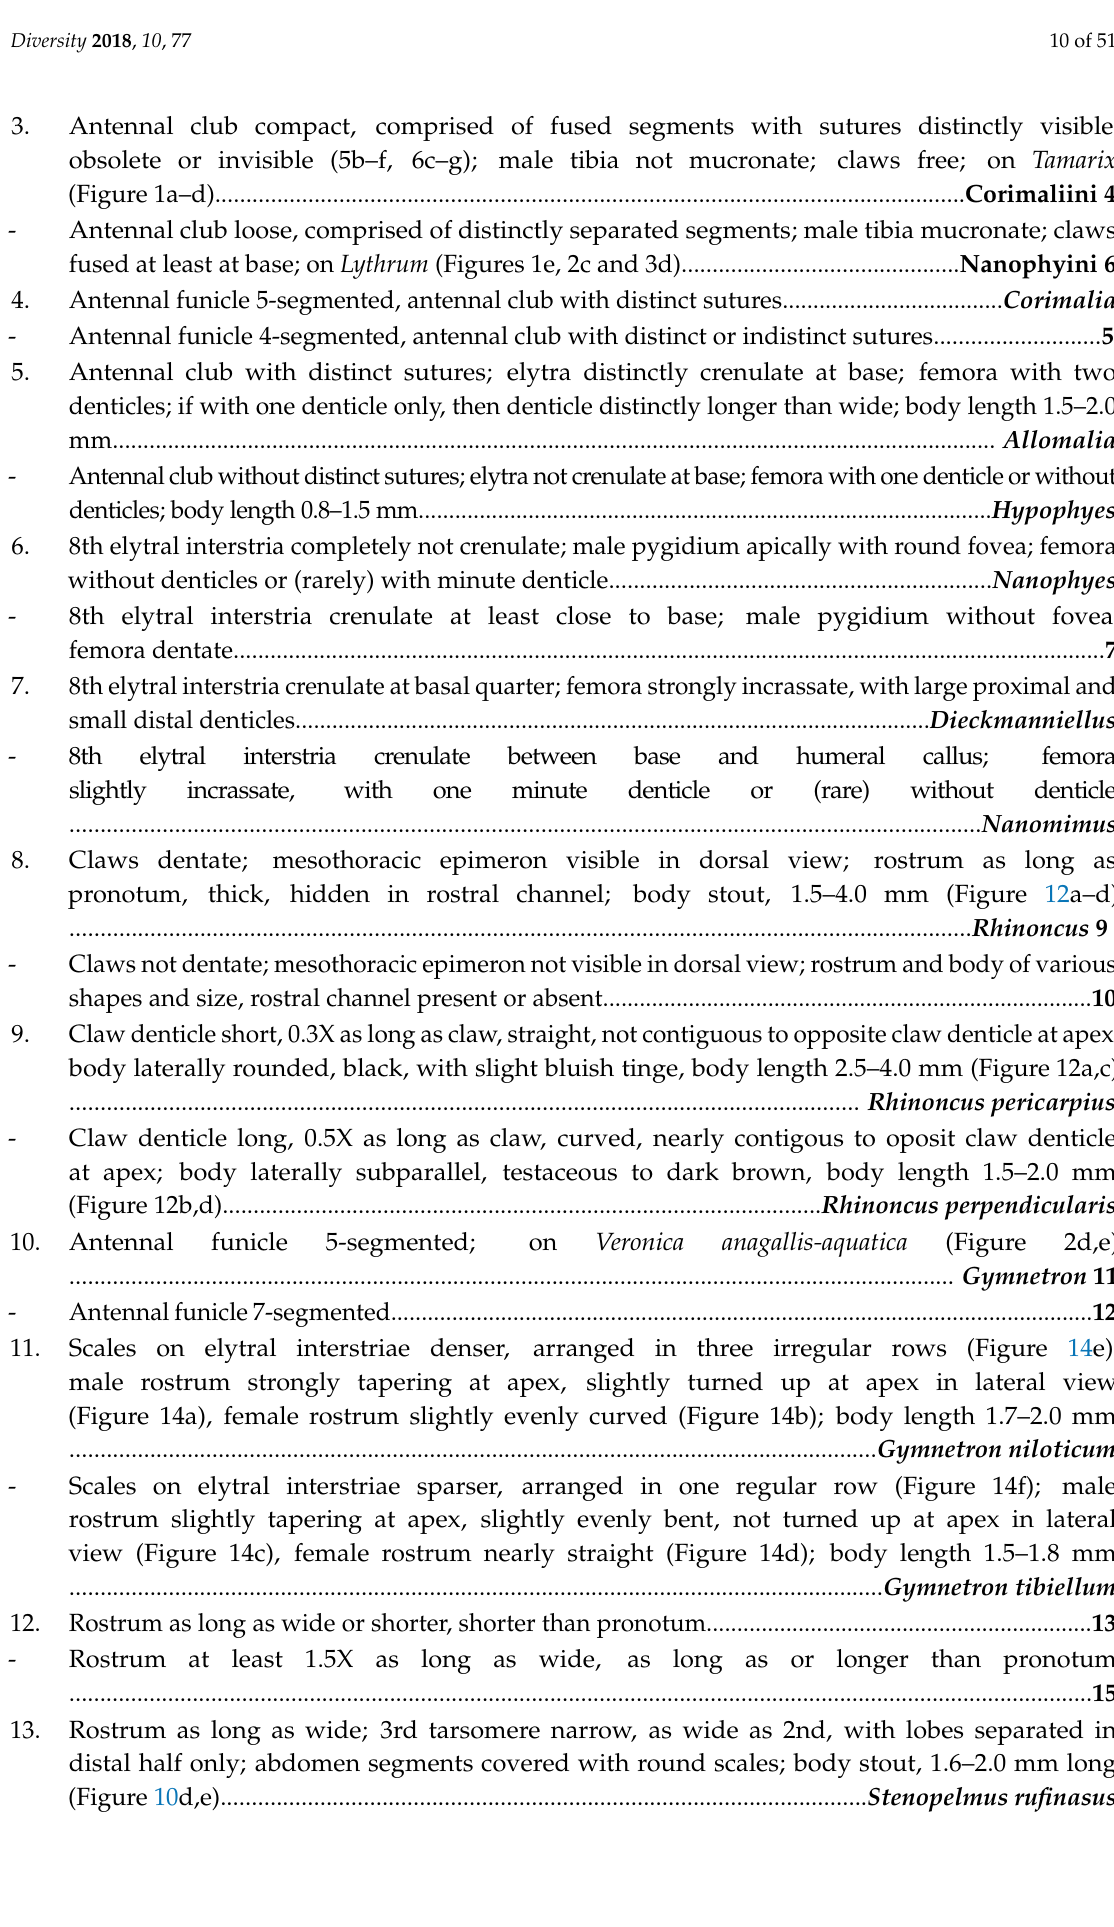
3. Antennal club compact, comprised of fused segments with sutures distinctly visible, obsolete or invisible (5b–f, 6c–g); male tibia not mucronate; claws free; on Tamarix - Antennal club loose, comprised of distinctly separated segments; male tibia mucronate; claws fused at least at base; on Lythrum (Figures 1e, 2c and 3d)............................................. Nanophyini 6 4. Antennal funicle 5-segmented, antennal club with distinct sutures.................................... Corimalia - Antennal funicle 4-segmented, antennal club with distinct or indistinct sutures........................... 5 5. Antennal club with distinct sutures; elytra distinctly crenulate at base; femora with two denticles; if with one denticle only, then denticle distinctly longer than wide; body length 1.5–2.0 - Antennal club without distinct sutures; elytra not crenulate at base; femora with one denticle or without 6.